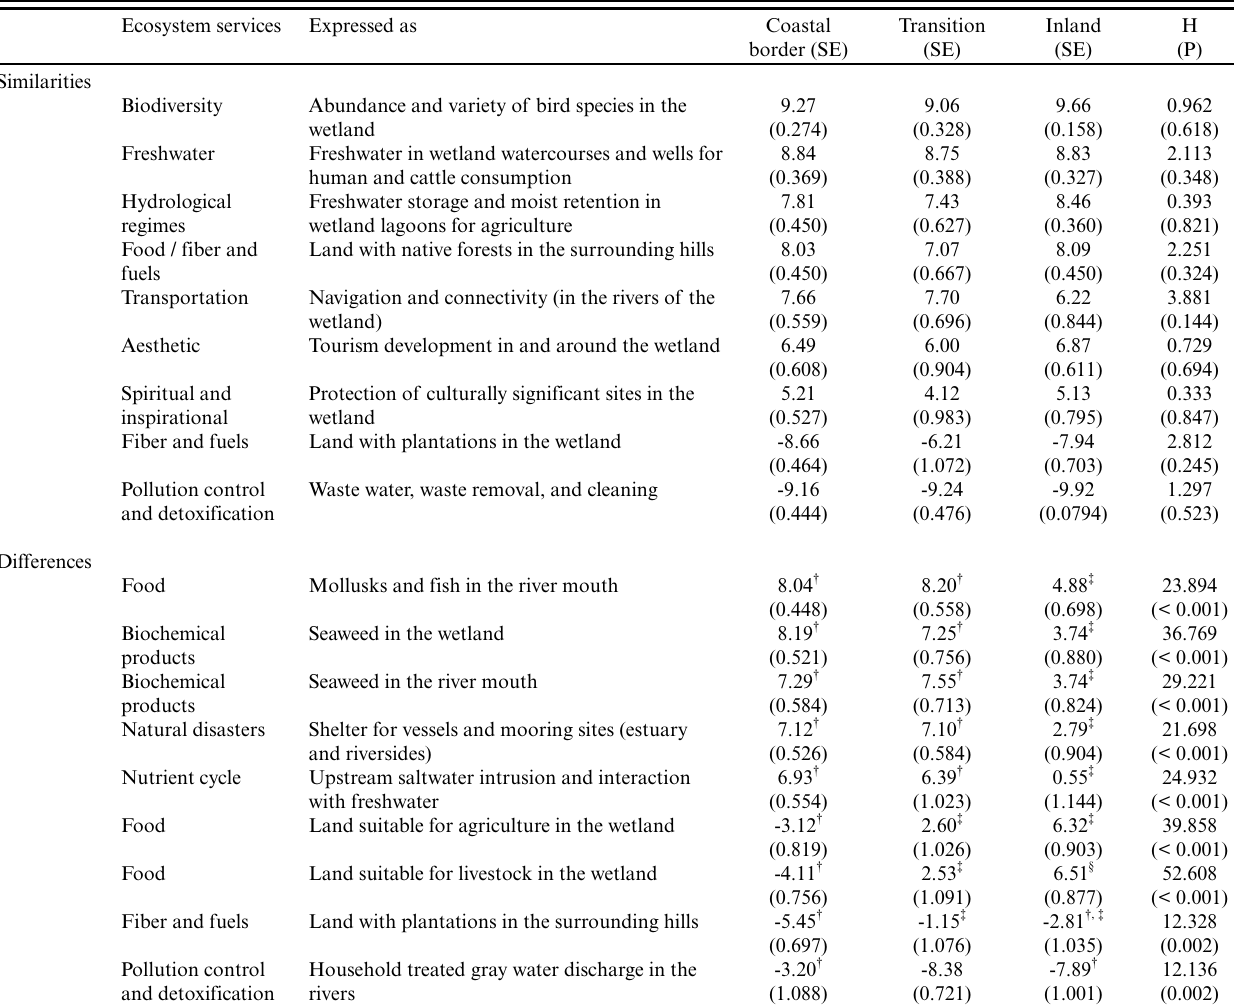
Table 2 . Similarities and differences in user groups” mean preferences for future ecosystem services